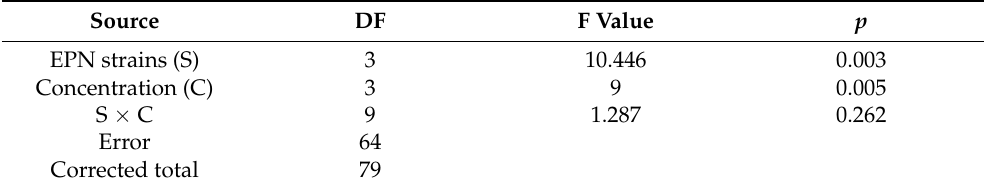
Table 2 . ANOVA parameters for the effects of entomopathogenic nematode strains, concentration, and their interactions on the mortality of Spodoptera frugiperda larvae over 84 h. Source DF F Value p EPN strains (S) 3 10.446 0.003 Concentration (C) 3 9 0.005 S × C 9 1.287 0.262 Error 64 Corrected total 79